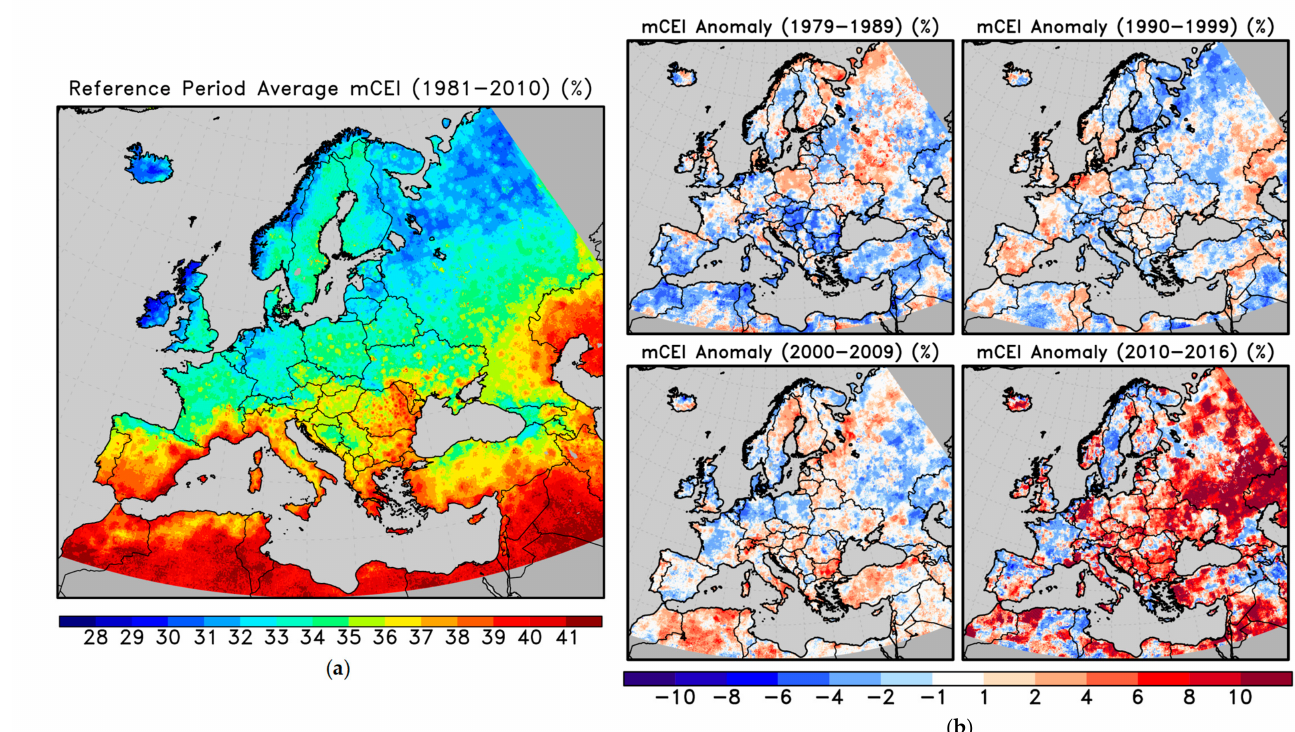
Figure 7. ( a ) Reference period (1981–2010) climatology, and ( b ) decadal anomalies of